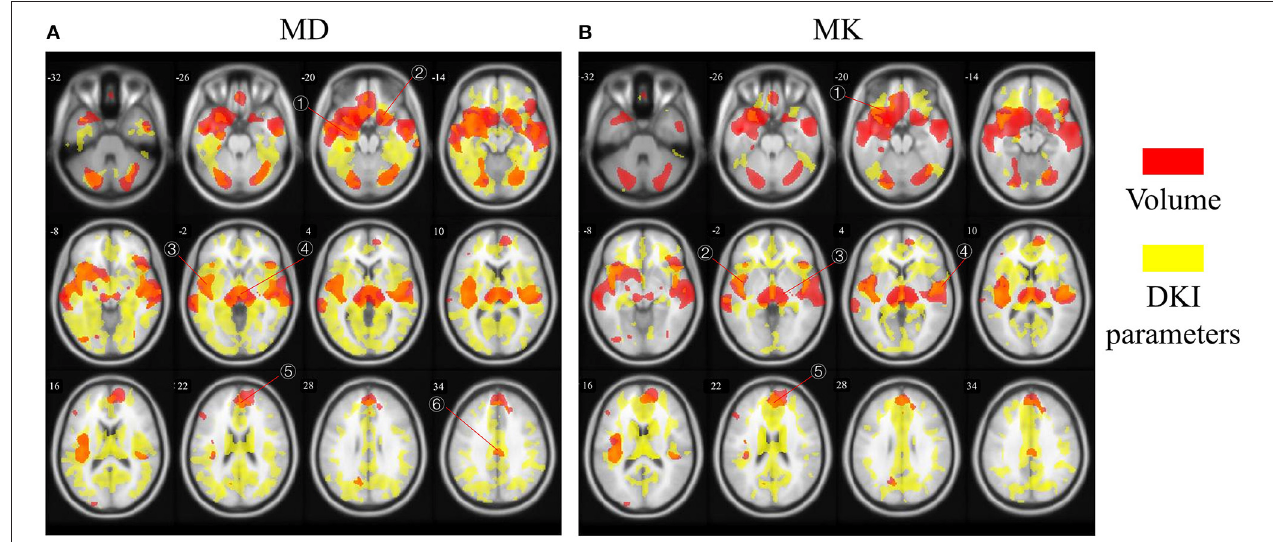
FIGURE 3 | The age-related regions of GM volume overlapped with MD and MK, respectively. Red areas represent GM volume changes, and yellow areas represent microstructural changes. The overlapped regions between (A) GM volume and MD and (B) GM volume and MK. The labled areas in (A) included: right superior temporal gyrus, left inferior frontal gyrus, left insula, thalamus, superior frontal gyrus, cingulum gyrus; in (B) included left inferior frontal gyrus, left insula, thalamus, superior frontal gyrus, transverse temporal